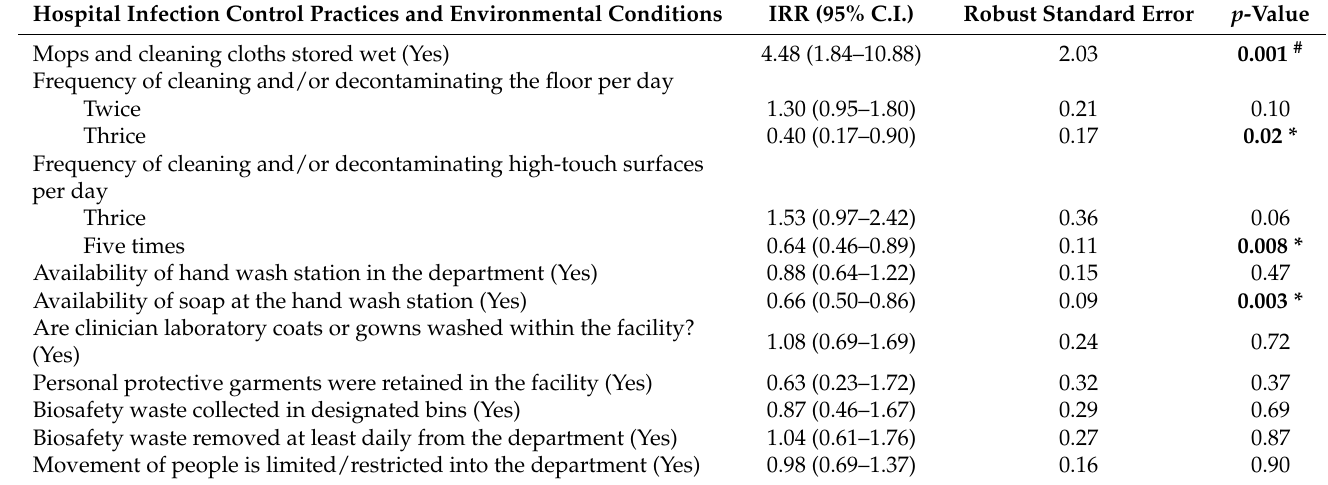
Table 4. Multivariate analysis of the influence of hospital IPC practices and environmental conditions on bacterial loads in the study